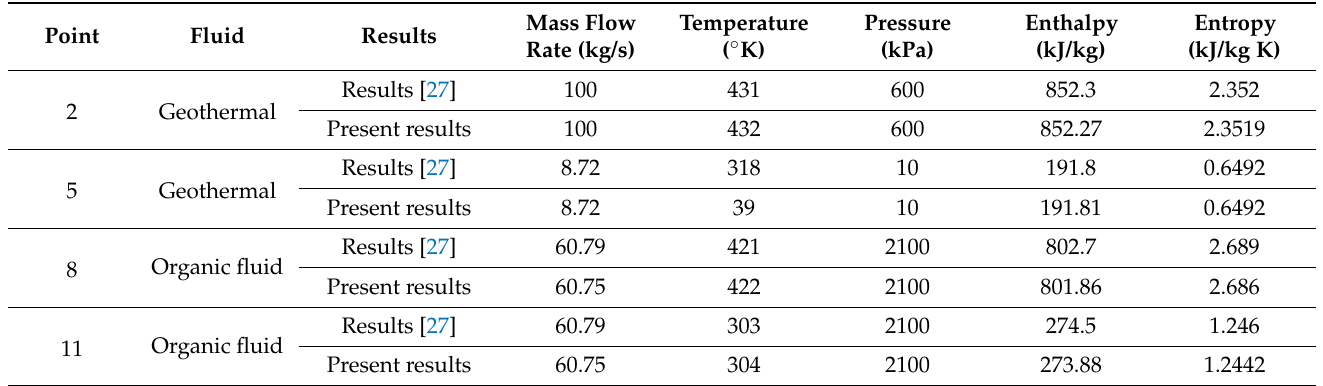
Table 5. The results of the present work are based on the work of Yilmaz et al. [27].